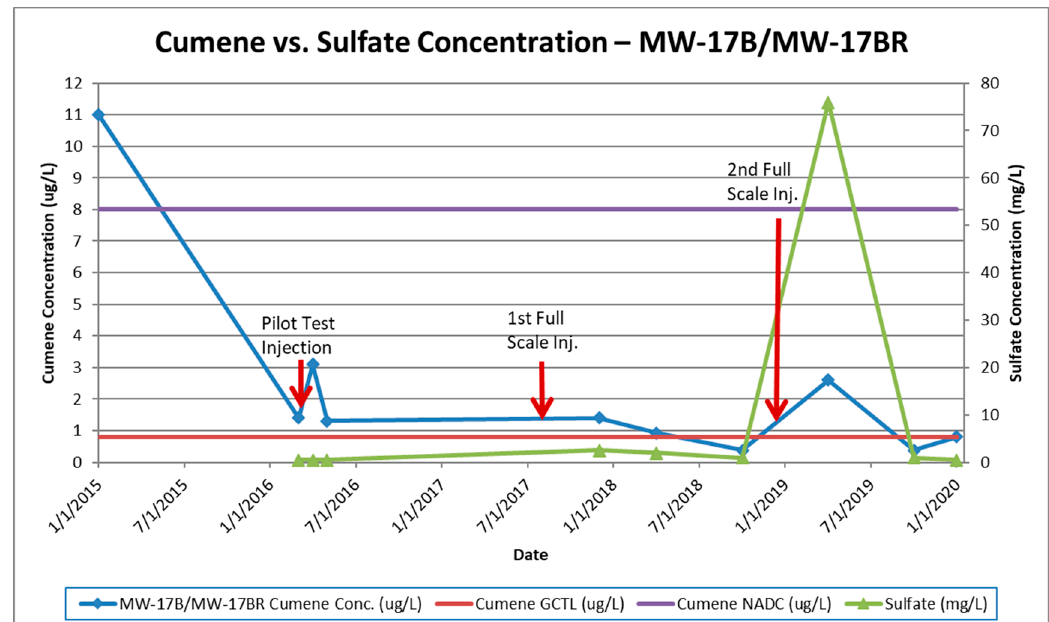
Figure 5. Cumene vs. sulfate concentrations in MW-17B/MW-17BR.